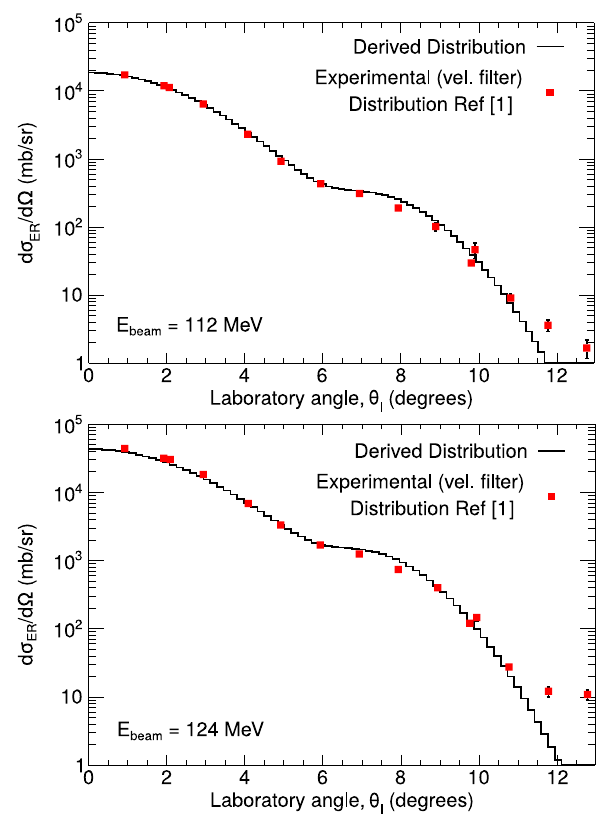
Figure 4. The di ff erential cross section d σ ER / d Ω as a function of laboratory angle, θ l , for E beam = 112 MeV (top) and E beam = 124 MeV (bottom). The results of the minimisation routine are shown as black histograms, while independent experimental data [1] are shown by red